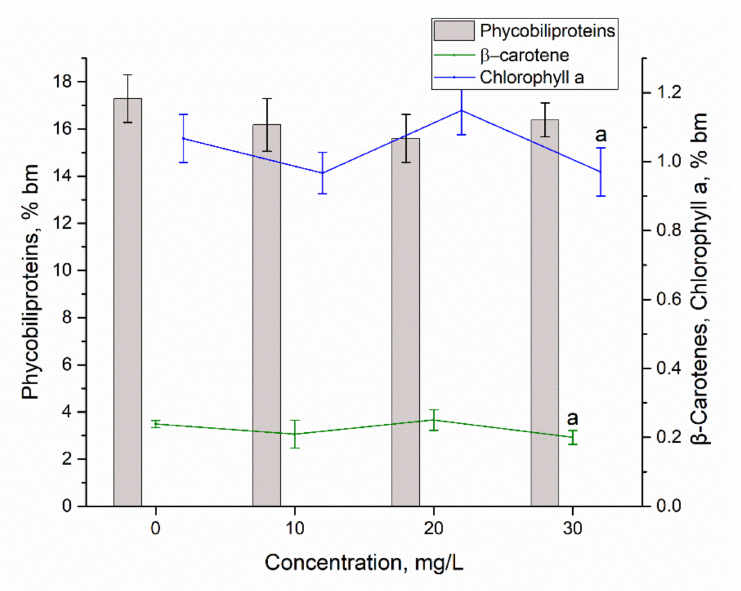
Figure 7. The content of pigments in A. platensis biomass exposed to Eu(III) in concentrations 10–30 mg/L (a— p <0.01 for the difference between sample and